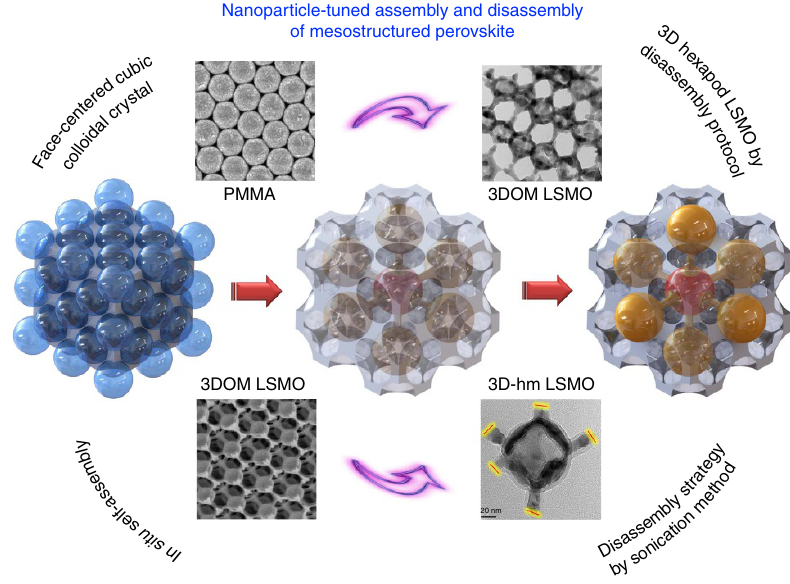
Figure 1 | Synthesis steps of 3D-hm LSMO. Schematic illustration depicting synthesis of the 3D-hm LSMO